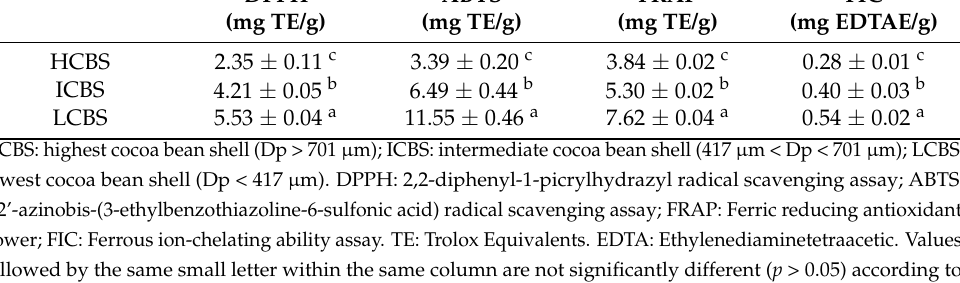
Table 6. Effect of particle size on antioxidant properties of cocoa bean shell flours.